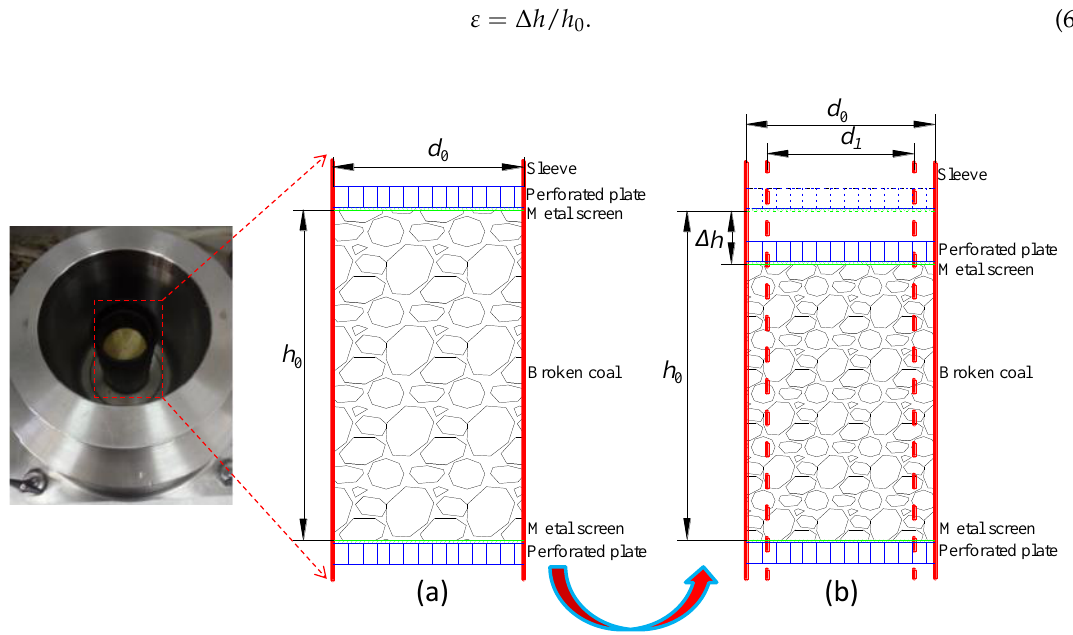
Figure 10. Calculation of strain and porosity:( a ) before the seepage test ( b ) after the seepage test.